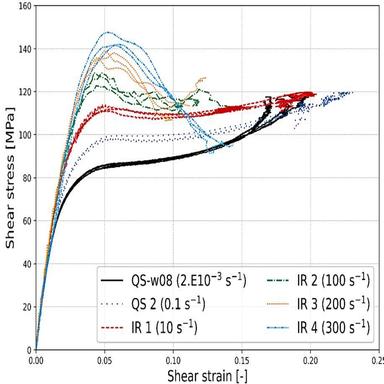
Comparison of quasi-static and dynamic in-plane shear stress-strain data obtained from ± 45◦ tensile specimens.